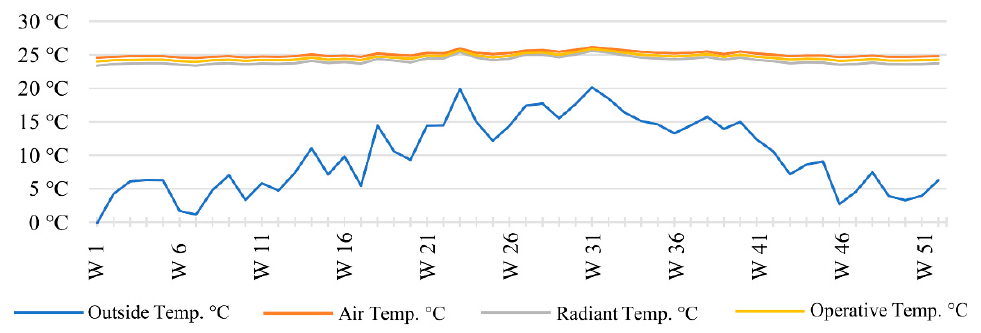
Figure 11. Weekly (W) temperatures of the farming system.